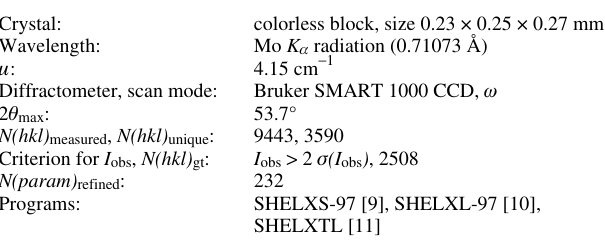
Table 1. Data collection and handling.